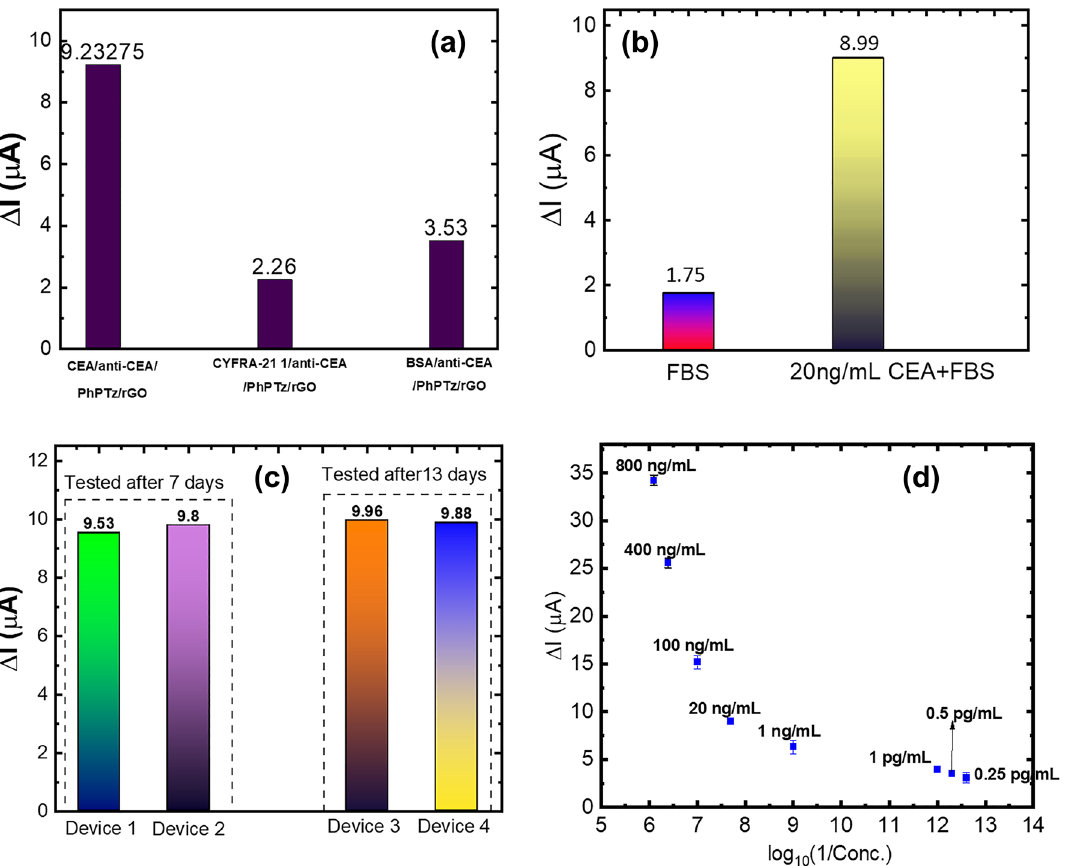
Figure 6. ( a ) Cross-reactivity results for biosensors for 20 ng/mL CEA. ( b ) Response of anti-CEA/PhPTz/rGO to FBS and FBS + 20 ng/mL CEA. ( c ) Stability test results of anti-CEA/PhPTz/rGO sensors to 20 ng/mL of CEA. ( d ) Variation in sensors’ response with different devices having different baseline currents. Sl.